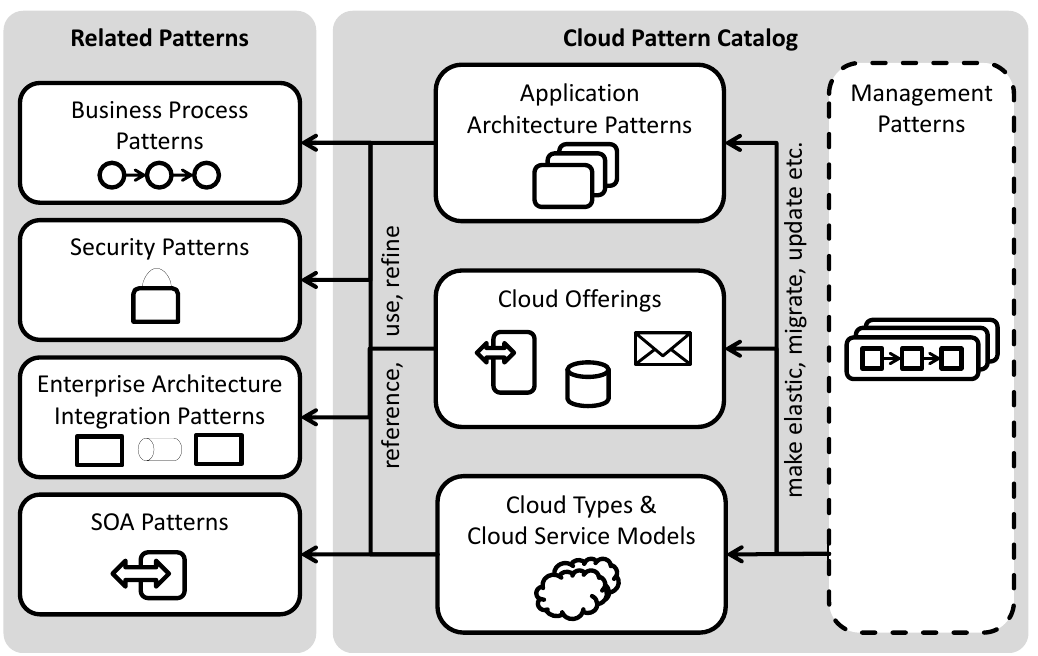
Figure 3. Pattern Classes Comprising the Pattern Catalog and their Relations to Existing